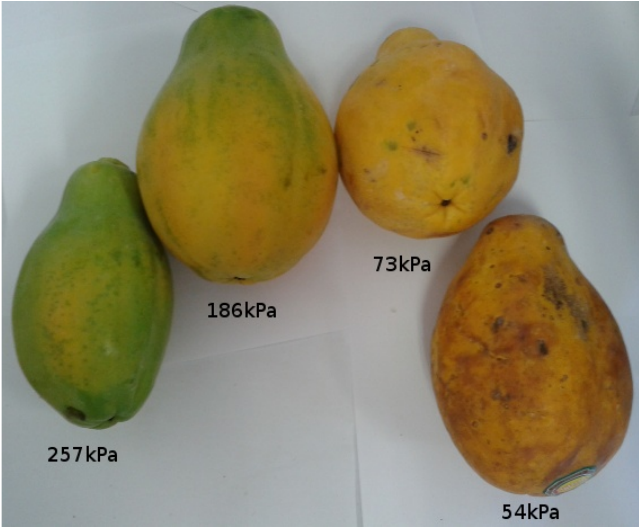
Figure 14. Turgor pressure in Kilo-Pascal (kPa) measured with the glove for papaya. The fruit on the left is more unripe and the one on the right is more ripe.